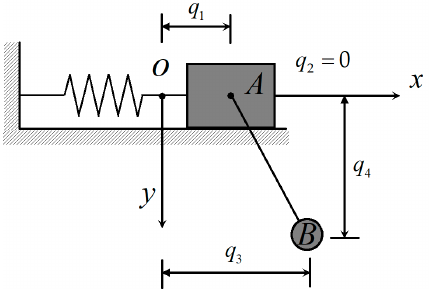
Figure 1. Nonlinear spring-pendulum.